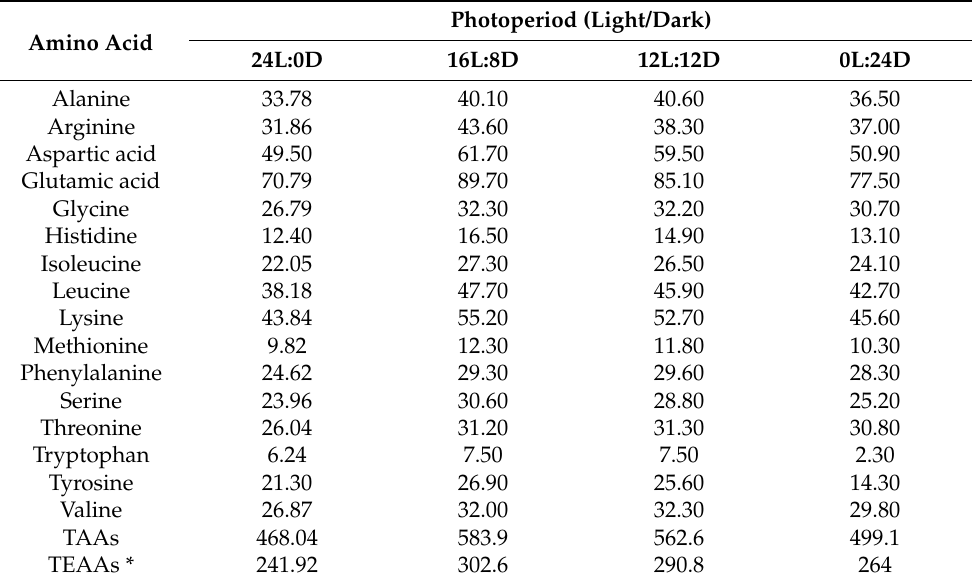
* Total amino acids (TAAs); Total essential amino acids (TEAAs). Similar to other animals, arginine, histidine, isoleucine, leucine, lysine, methionine, phenylalanine, threonine, tryptophan, and valine were considered as essential amino